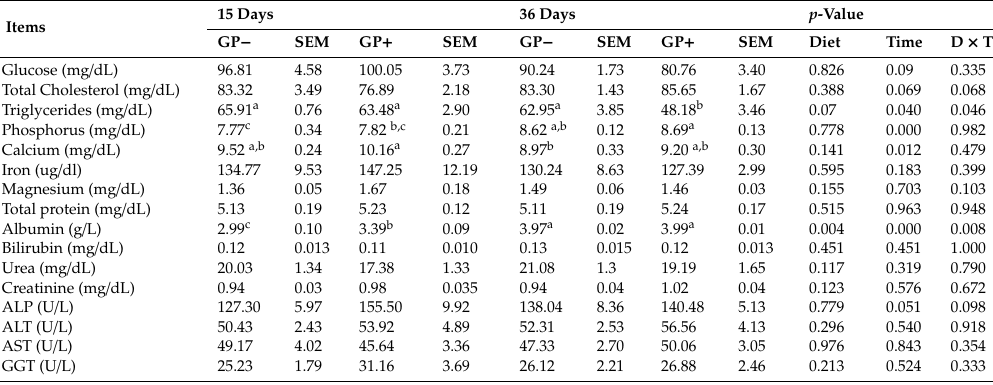
Table 3. E ff ects of grape pomace (GP) diet on selected blood biochemical parameters *.